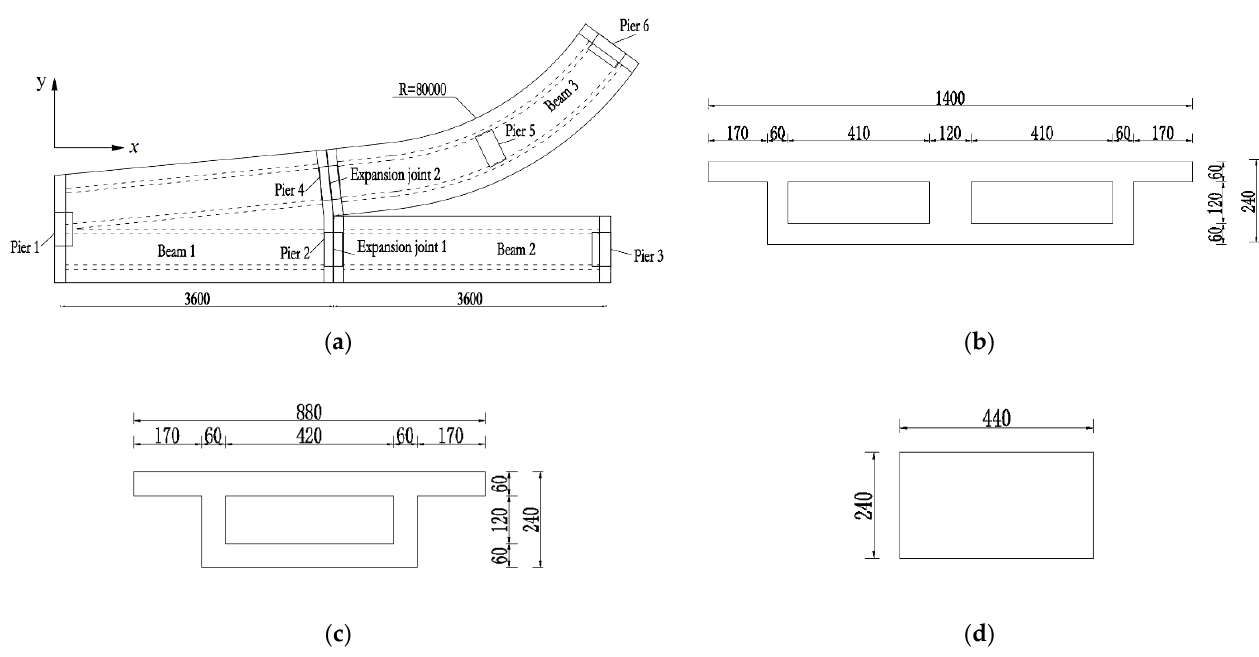
Figure 2. Bridge and sections (cm). ( a ) Span arrangement of the bridge; ( b ) Section of beam 1; ( c ) Section of beam 2 and beam 3; ( d ) Section of piers.